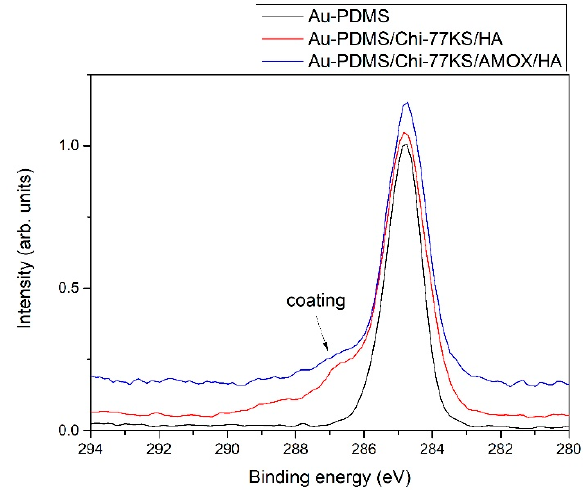
Figure 5. Comparison of high-resolution XPS spectra of carbon C1s of Au-PDMS, Au-PDMS/Chi- 77KS/HA, and Au-PDMS/Chi-77KS/AMOX/HA.